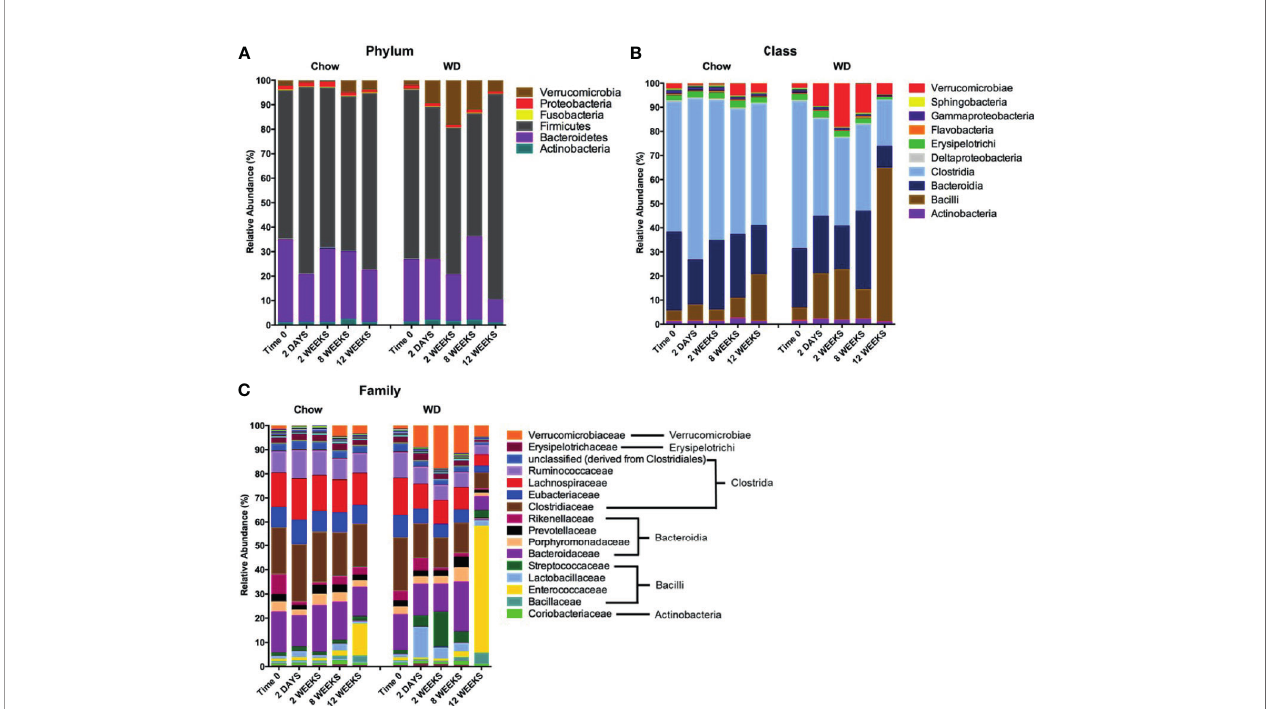
FIGURE 5 | Changes in relative abundance of microbial composition after administration of the Western diet. (A) Phylum, (B) Class and (C) Family level bacterial composition in mice fed Chow or WD after 2 days, 2, 8 and 12 weeks of dietary exposure. The mean relative abundance (%) of bacterial phyla are shown. Statistical results outlined in Tables S1 – S3